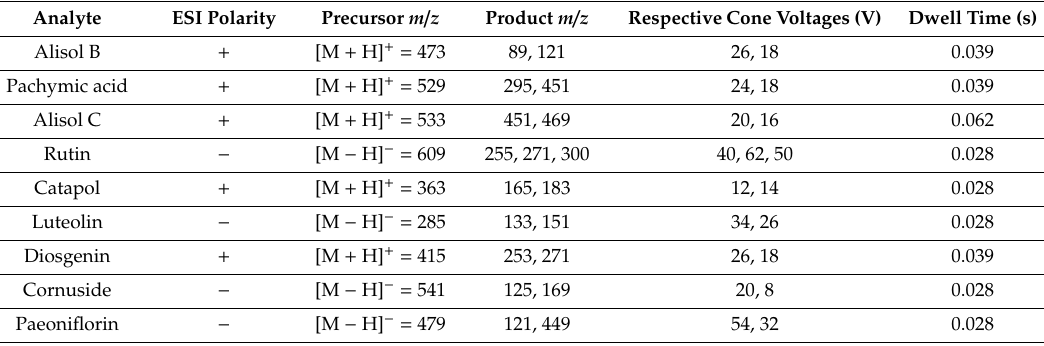
Table 5. The UPLC-MS / MS monitoring